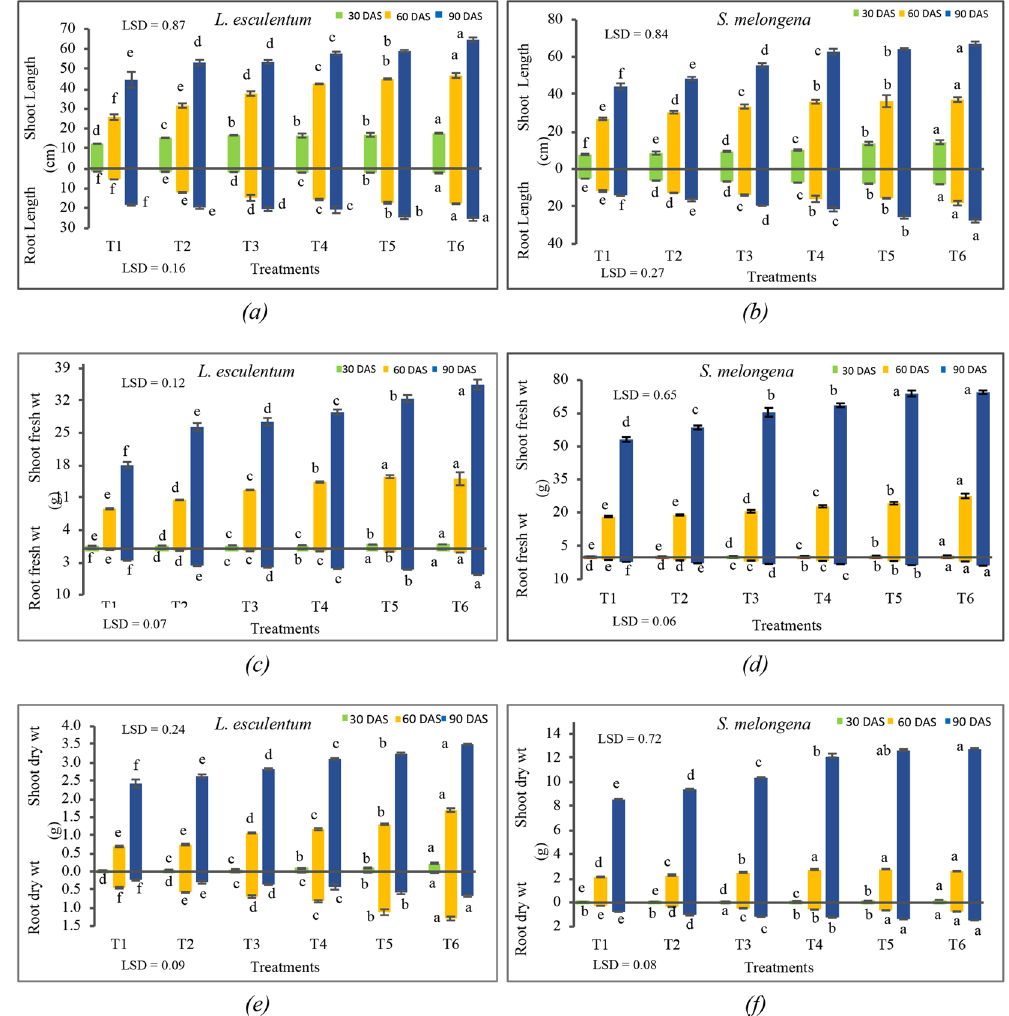
Figure 4. Effects of vermicomposted fly ash on the shoot and root length, shoot and root fresh weight and shoot and root dry weight of Lycopersicon esculentum and Solanum melongena at different .durations after sowing in different treatments Illustration: Values are in Mean ± SD; (n = 3). Means with bars of different colours followed by the same letter are not significantly different at p < 0 . 05 (One-way ANOVA followed by Least significance difference test). The normality and homogeneity of variances were verified, respectively, by Shapiro-Wilk and Levene values at p > 0 . 05